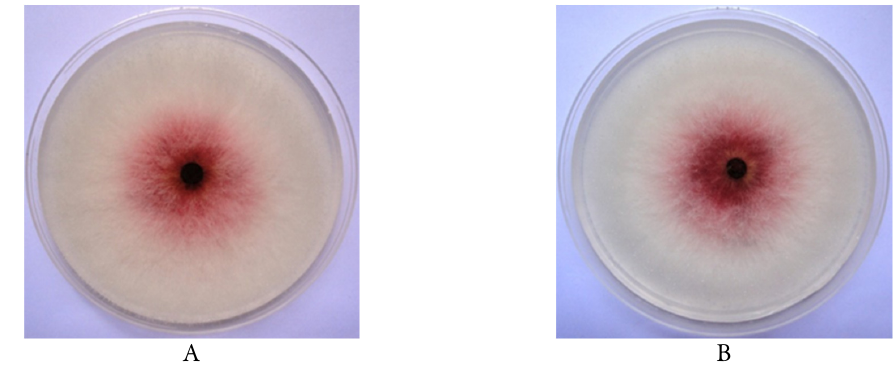
Figure 1. Cultural aspect of colonies on PDA medium of both isolates after 4 days of incubation at 25 °C and in the dark (young cultures) A: F.C.T5 isolate, B: F.G.10.08 isolate